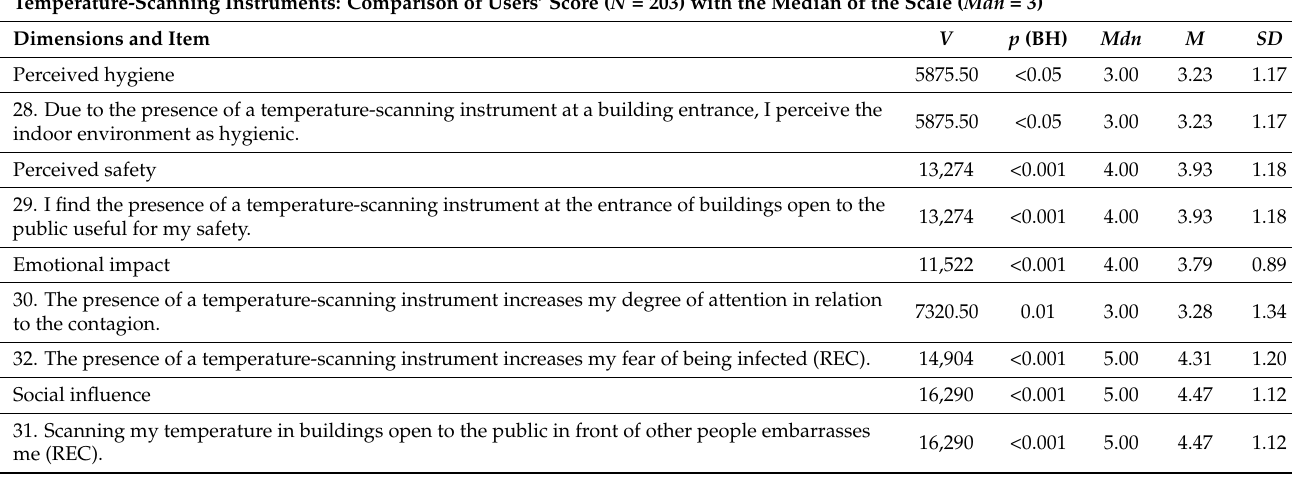
Table A2. Table illustrating the values of Wilcoxon test comparing the scores that participants assigned to each dimension with the median value of the scale ( V , p (BH), median ( Mdn ), means ( M ), and standard deviations ( SD )) reported for the temperature-scanning instruments. Own